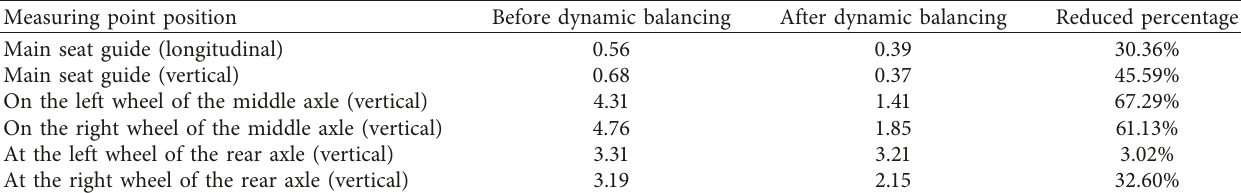
Table 6: Acceleration comparison before and after dynamic balancing (m/s 2